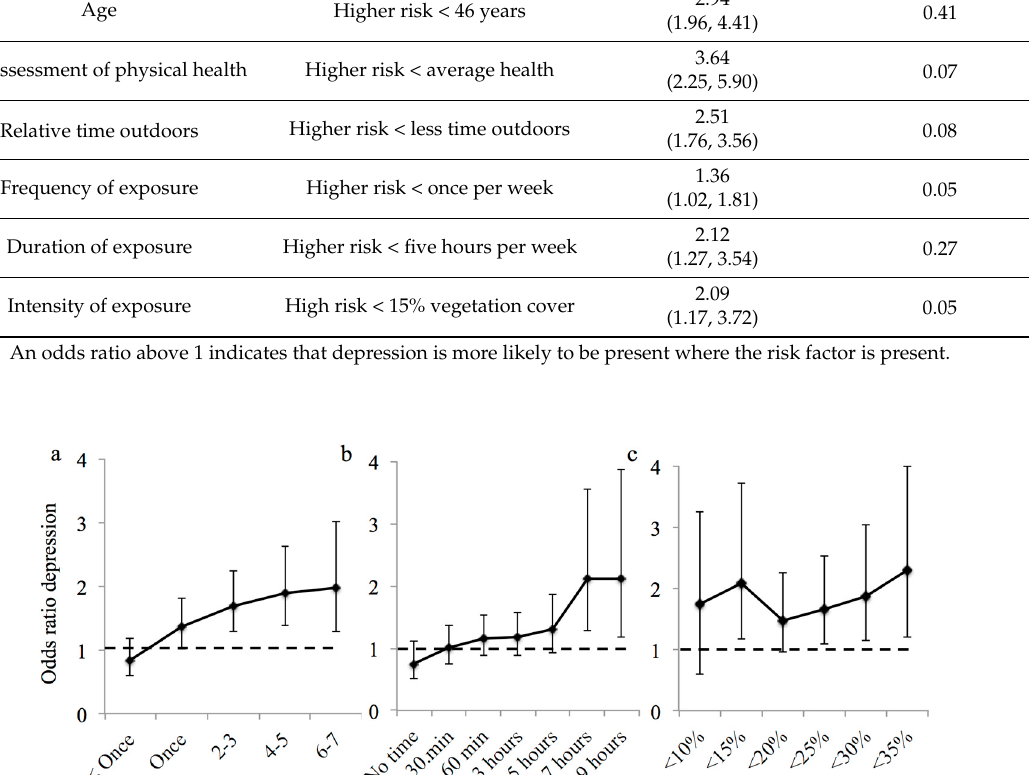
Table 2. Odds ratio and average attributable fraction of having depression where specific risk factors are present.